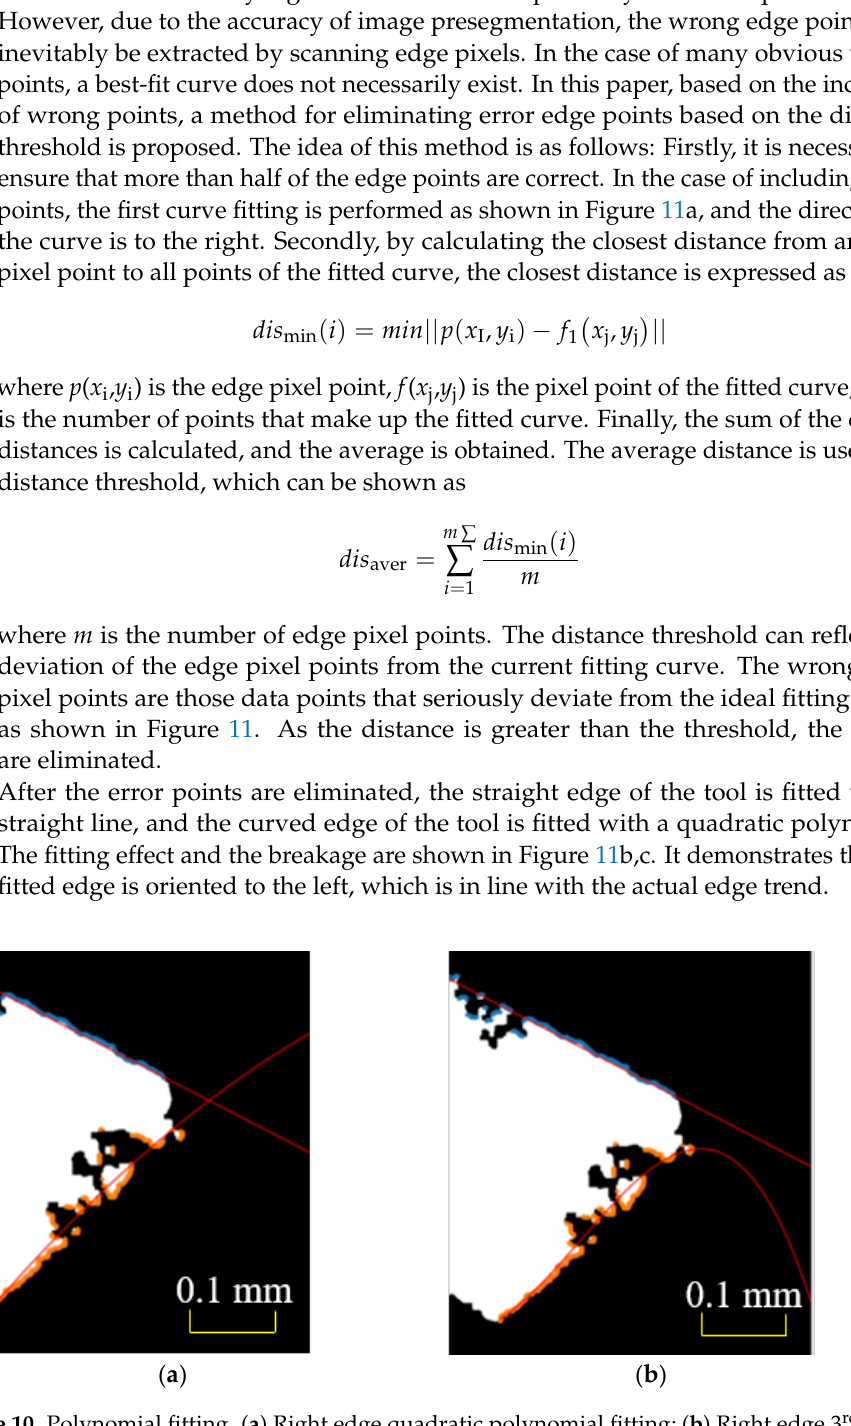
Figure 10. Polynomial fitting. ( a ) Right edge quadratic polynomial fitting; ( b ) Right edge 3rd-order polynomial fitting.